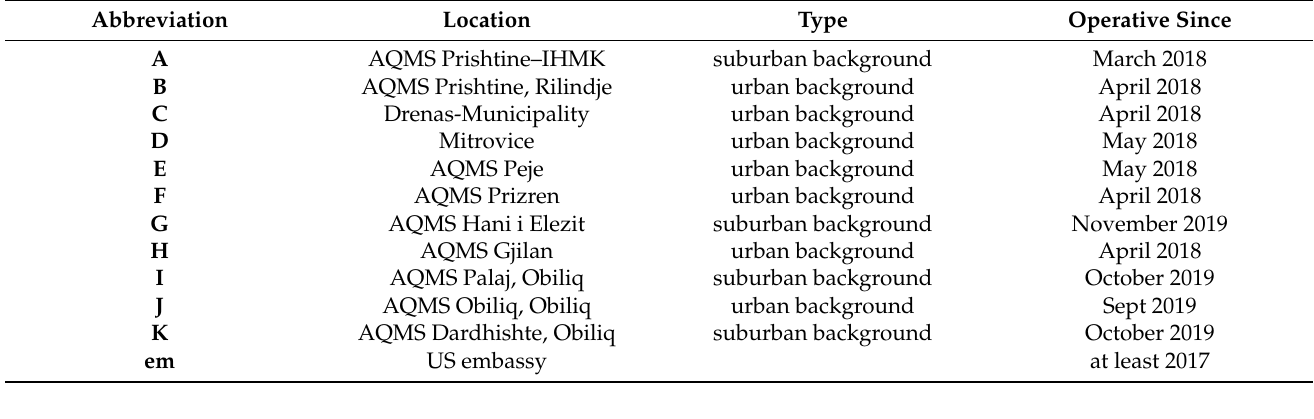
Table A4. Description of monitoring stations.